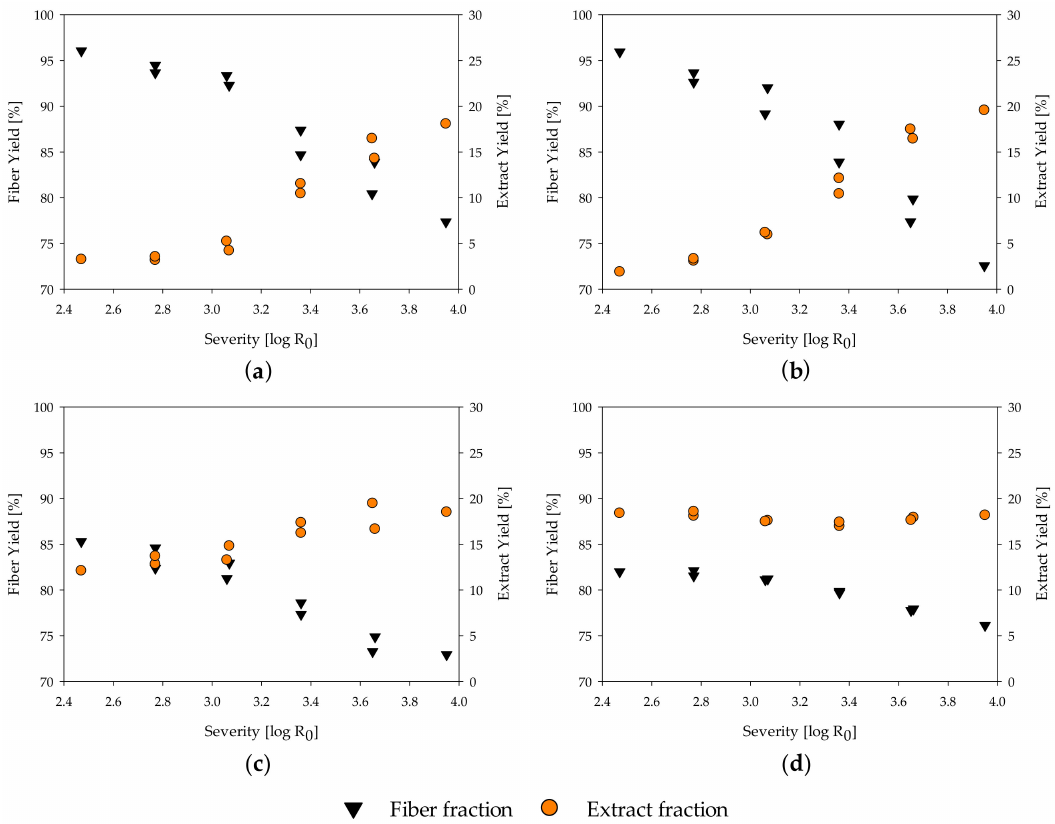
Figure 1. Influence of severity on yield of extract and fiber fraction of ( a ) poplar; ( b ) spruce; ( c ) MDF Sample A; ( d ) MDF Sample